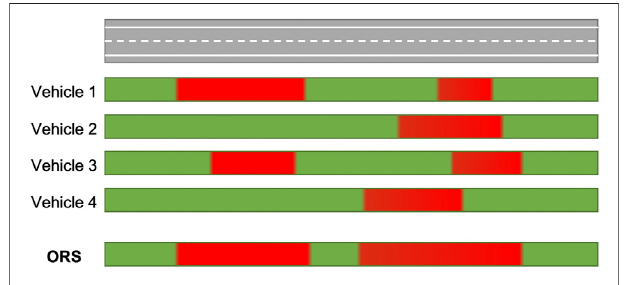
FIGURE 1 | Operational Road Sections along a road